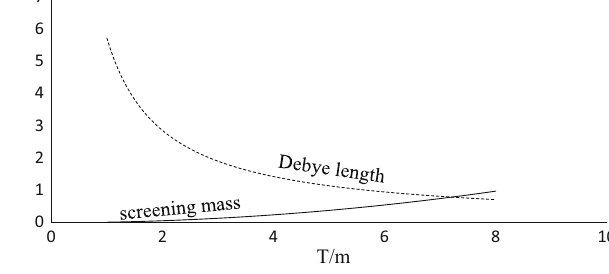
Fig. 5 Plotofplasmascreeningmass(solidline)andthecorresponding Debye shielding length (broken line) as a function of temperature in units of the electron mass